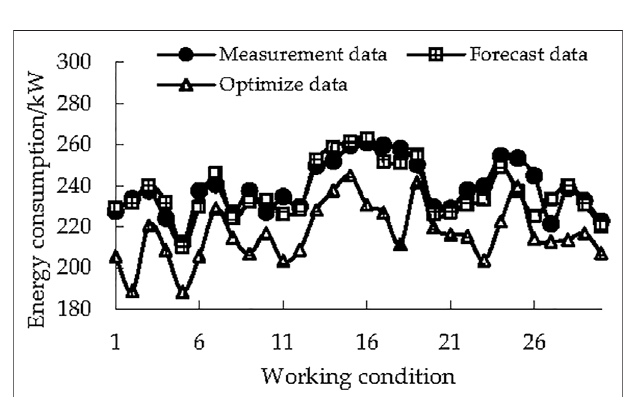
FIGURE 12 | Optimization, forecasting and actual energy consumption data for cold source system.